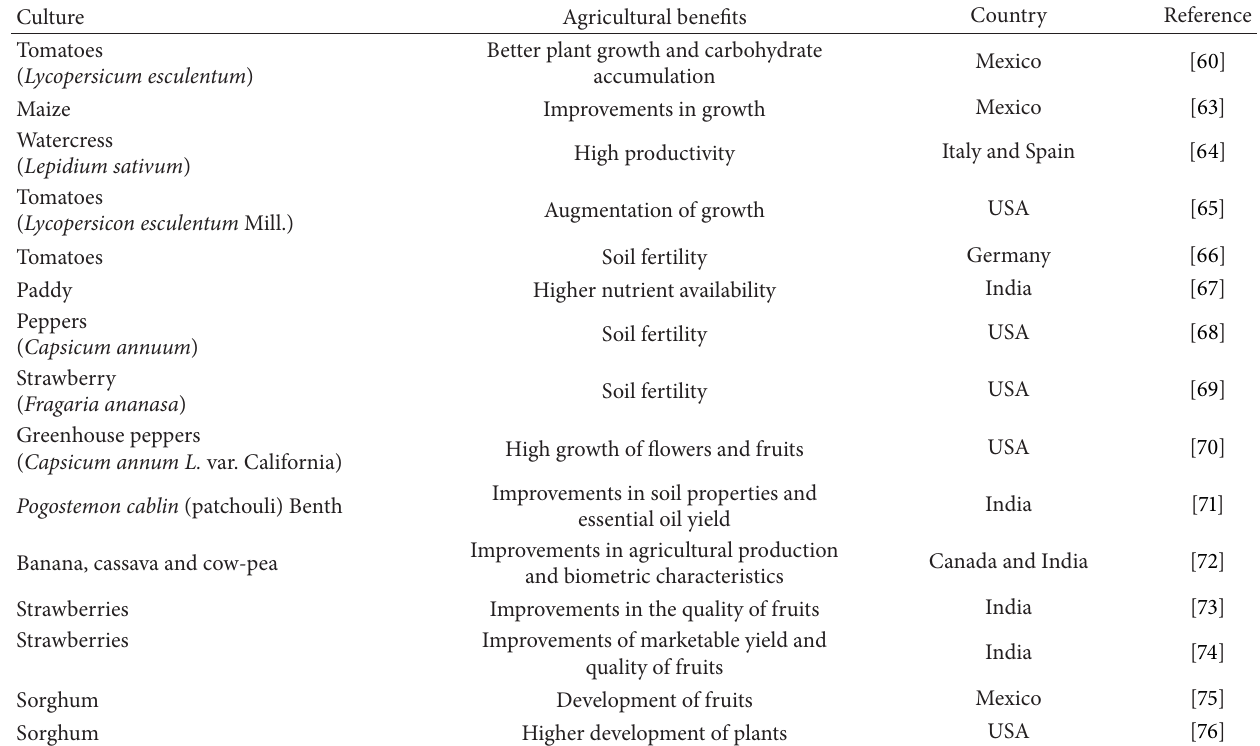
Table 2: Applications of vermicompost to increase agricultural